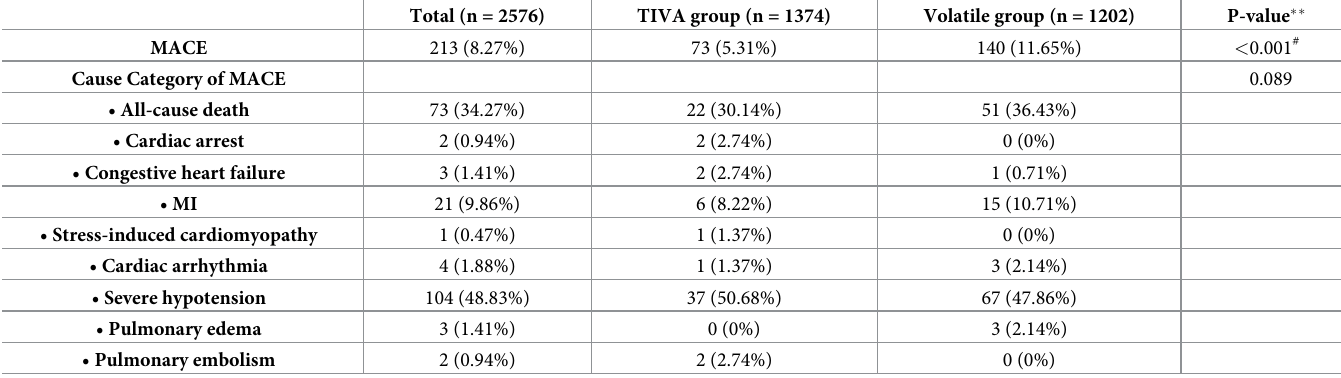
Table 3. Incidence of MACE and the